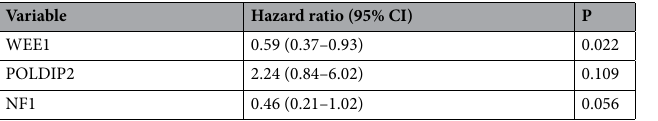
Table 6. Multivariate analysis based on the Cox model. $ Controlling for sex and age.